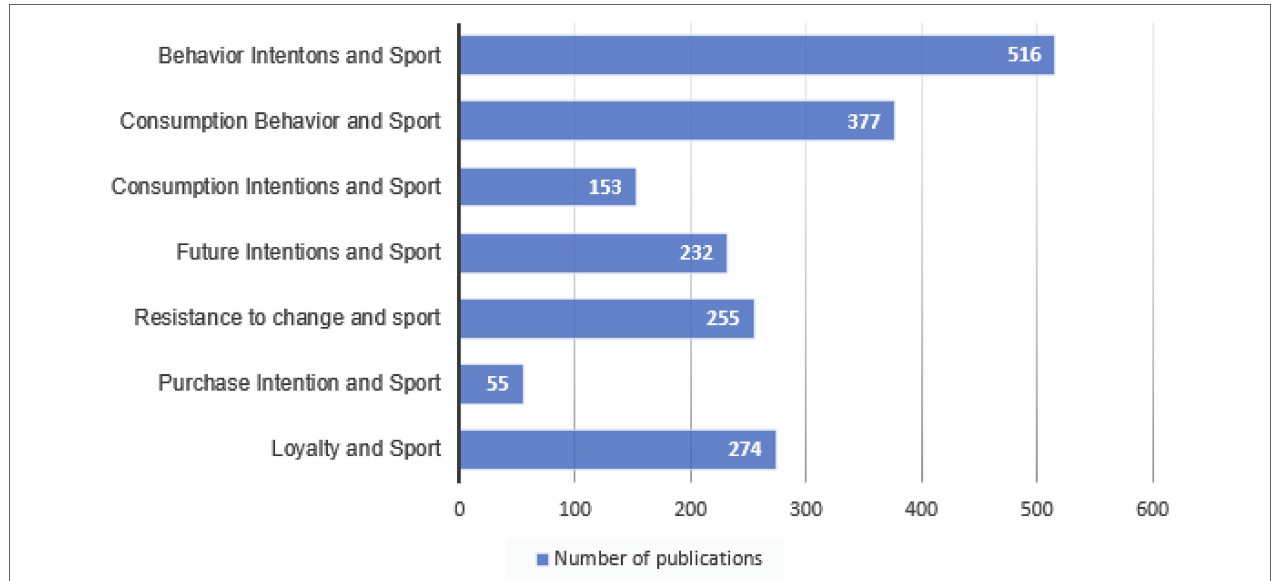
FIGURE 4 | Number of papers for loyalty in sport management and other terms related to loyalty.